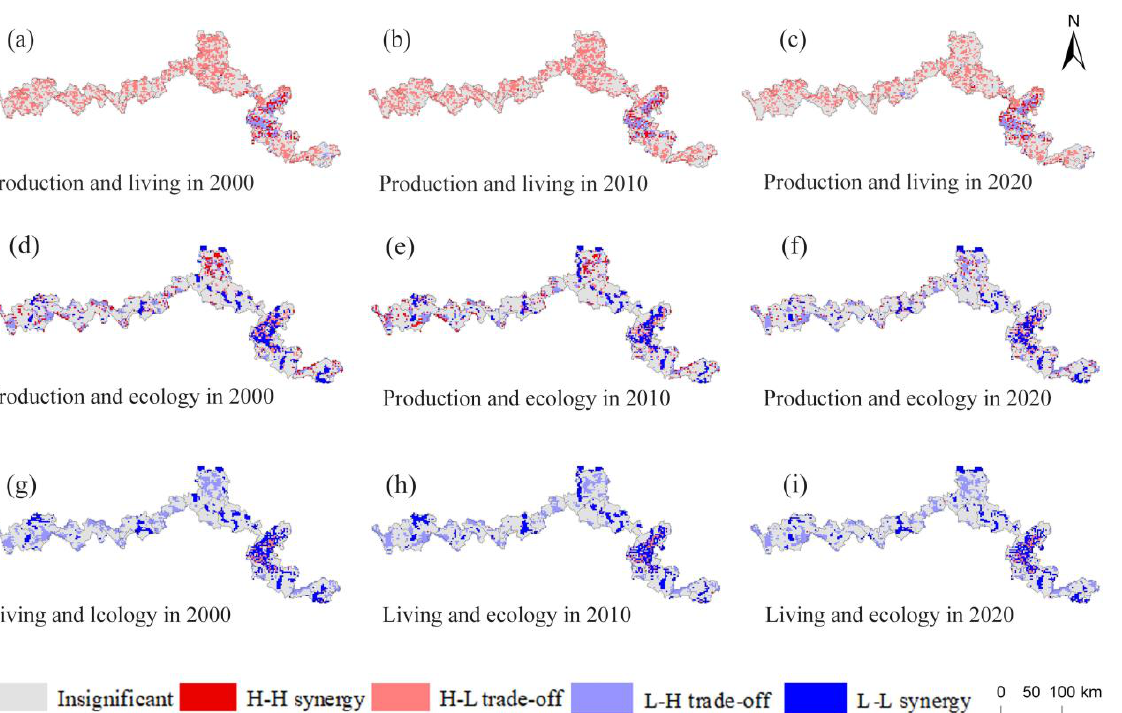
Figure 6. LISA cluster map of PLEF of the Sino-Vietnamese border area: ( a – c ) represent production function and living function in 2000 from 2020. ( d – f ) represent production function and ecology function in 2000 from 2020. And ( g – i ) represent living function and ecology function in 2000 from 2020.